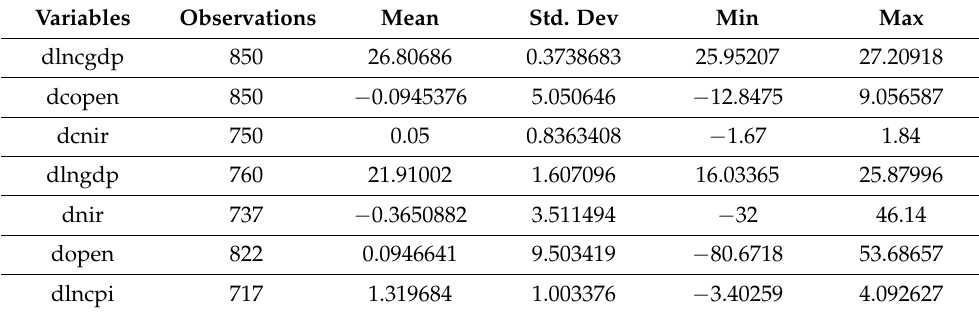
Table 2. Descriptive Statistic for Chinese Shocks.